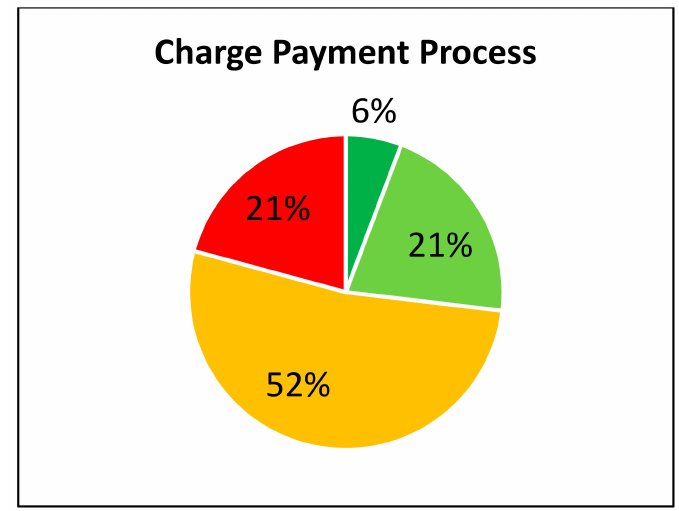
Figure 27. User charge payment process satisfaction.